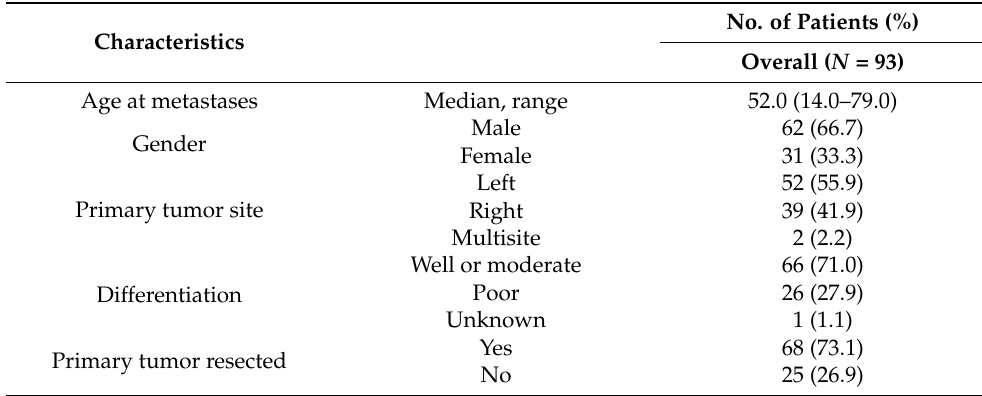
Table 1. Clinicopathological characteristics and therapeutic features of mCRC patients with the BRAF V600E mutation in our